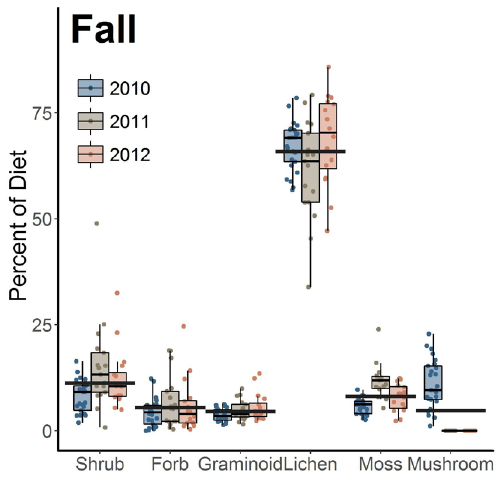
Figure 2. Early fall (September) diets of adult caribou from Onion Portage, Kobuk Valley National Park, northwest Alaska, 2010-2012. The thin bar inside the boxplots represents the median. The thick bar spanning all 3 years represents the 3-year mean.